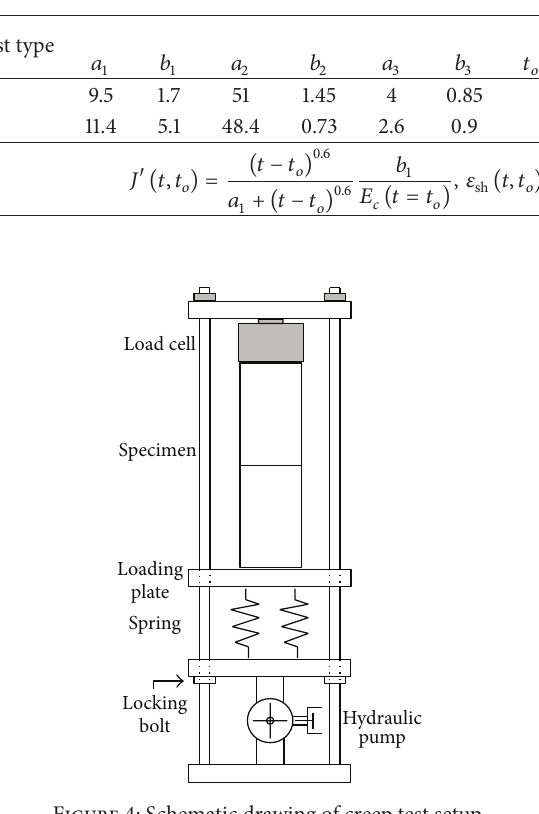
Table 2: Three empirical equations for the two types of tests.